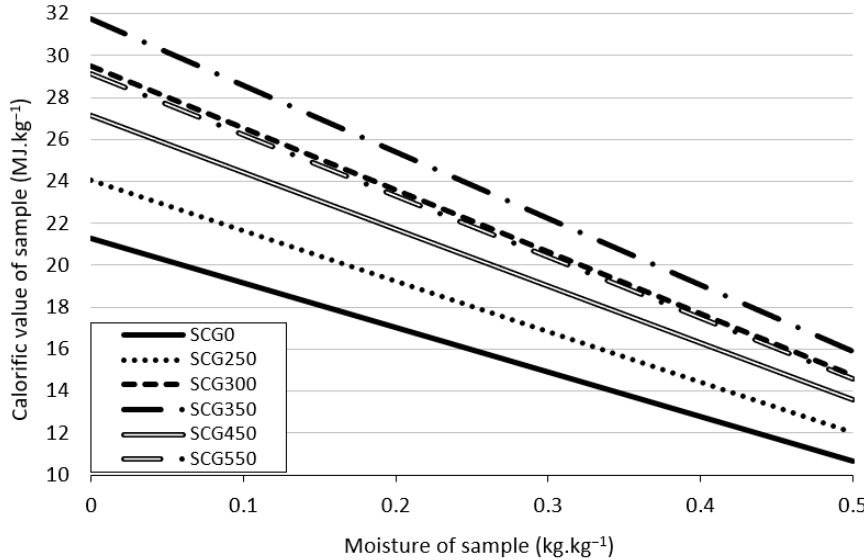
Figure 3. Net calorific value influenced by material moisture.